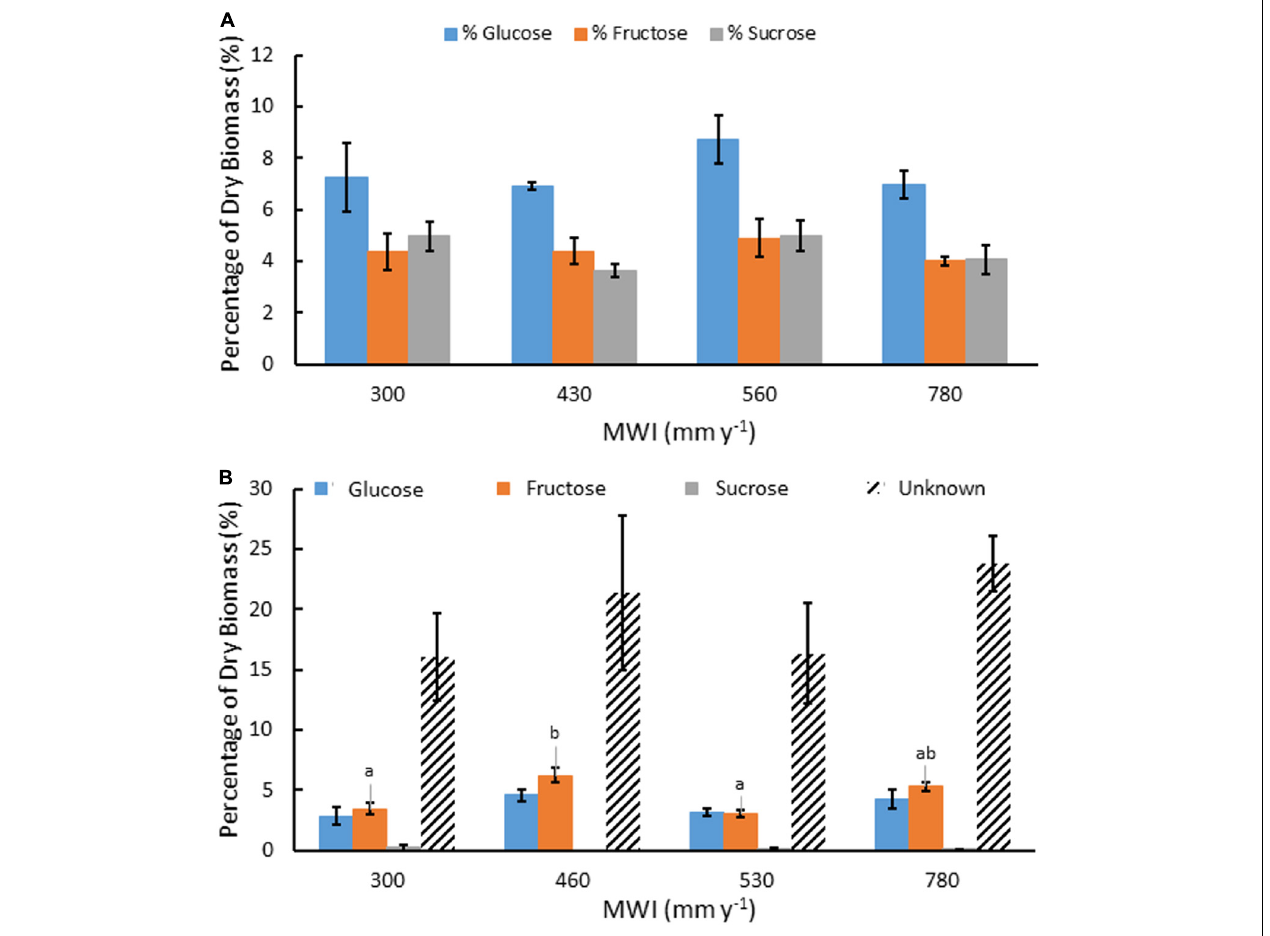
FIGURE 2 | Mean concentration of water soluble Glc, Fru and Suc as a percentage of dry biomass (A) and saccharides produced after TFA hydrolysis of water soluble extracts including Glc, Fru, Suc, and unknown sugars from oligosaccharides (B) , for A. americana under different MWI (mm y − 1 ). Error bars indicate standard error of the mean ( n = 4). Letters indicate significant differences between species in Fru ( p < 0.05) from one-way ANOVA and Tukey’s HSD test. No significant difference in the other sugars were observed between species ( p > 0.05).